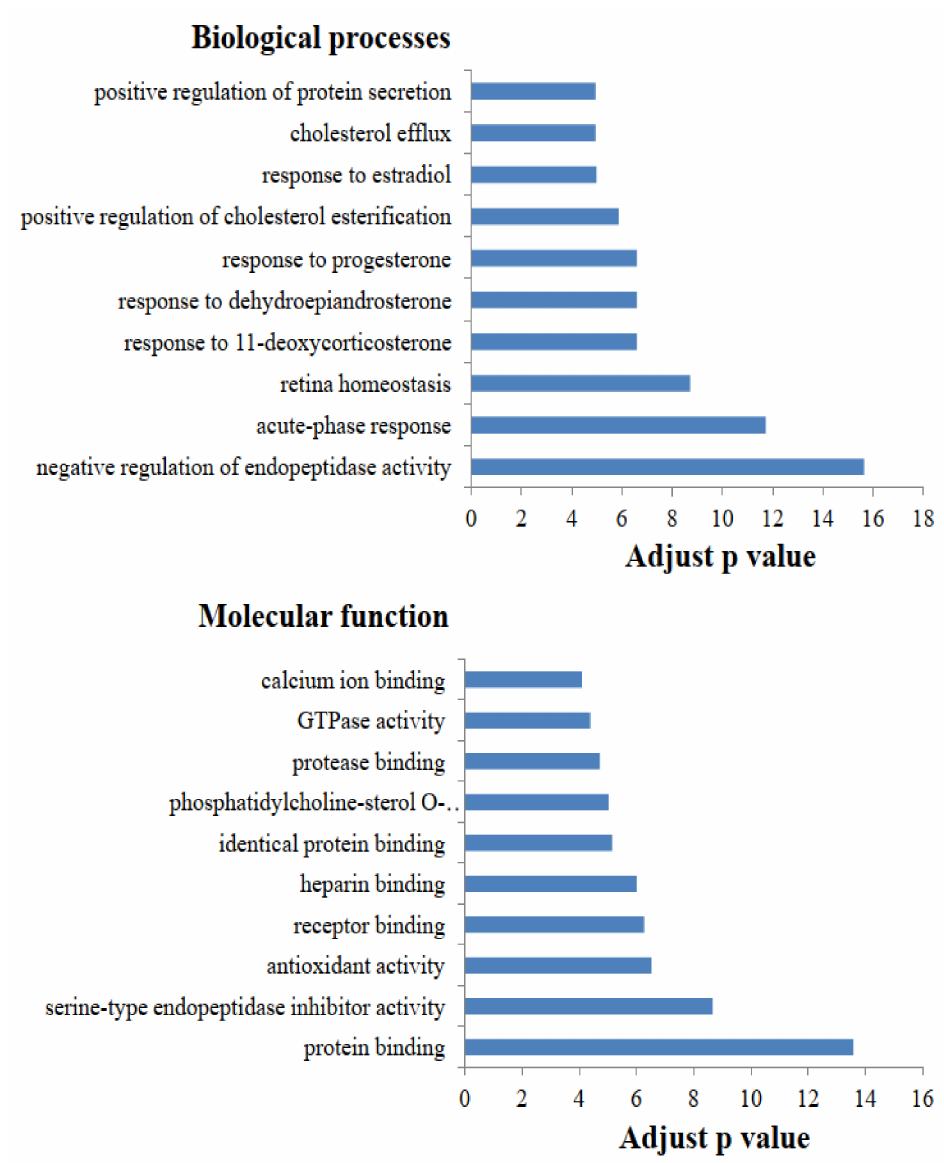
Figure 1. The top 10 biological processes and molecular function in the whey proteins of dairy cow milk (adjusted p value = −